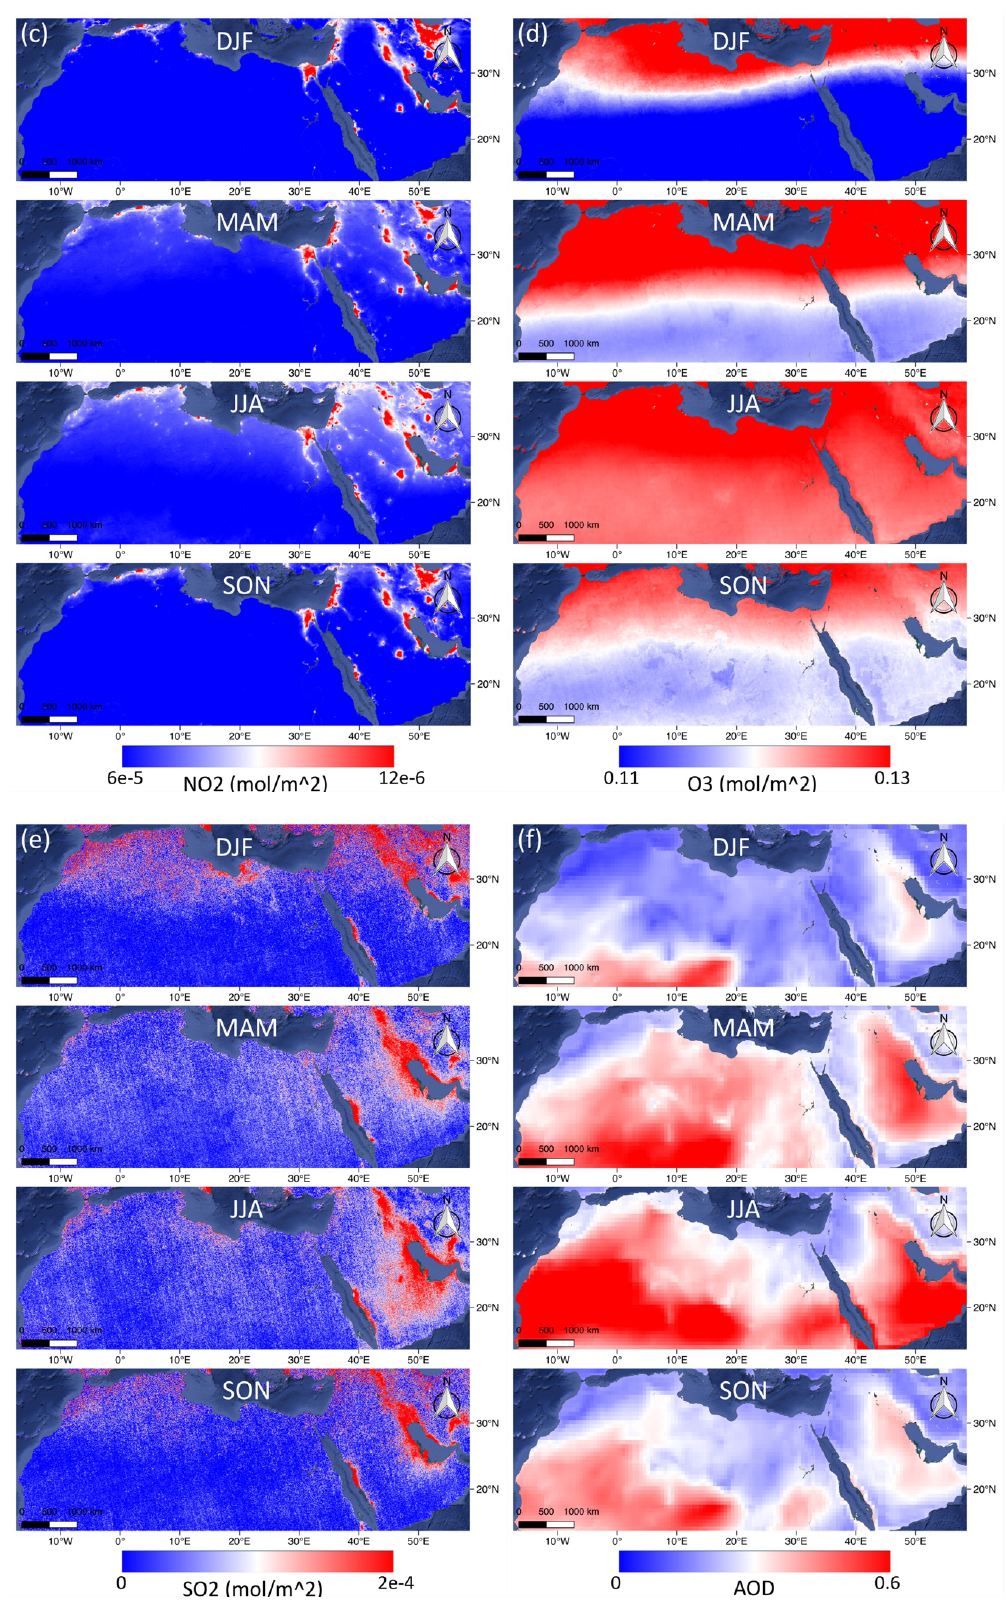
Figure 3. The maps of the TROPOMI (UVAI, CO, NO2, O3 SO2) and MERRA-2 AOD distribution of each season in the MENA